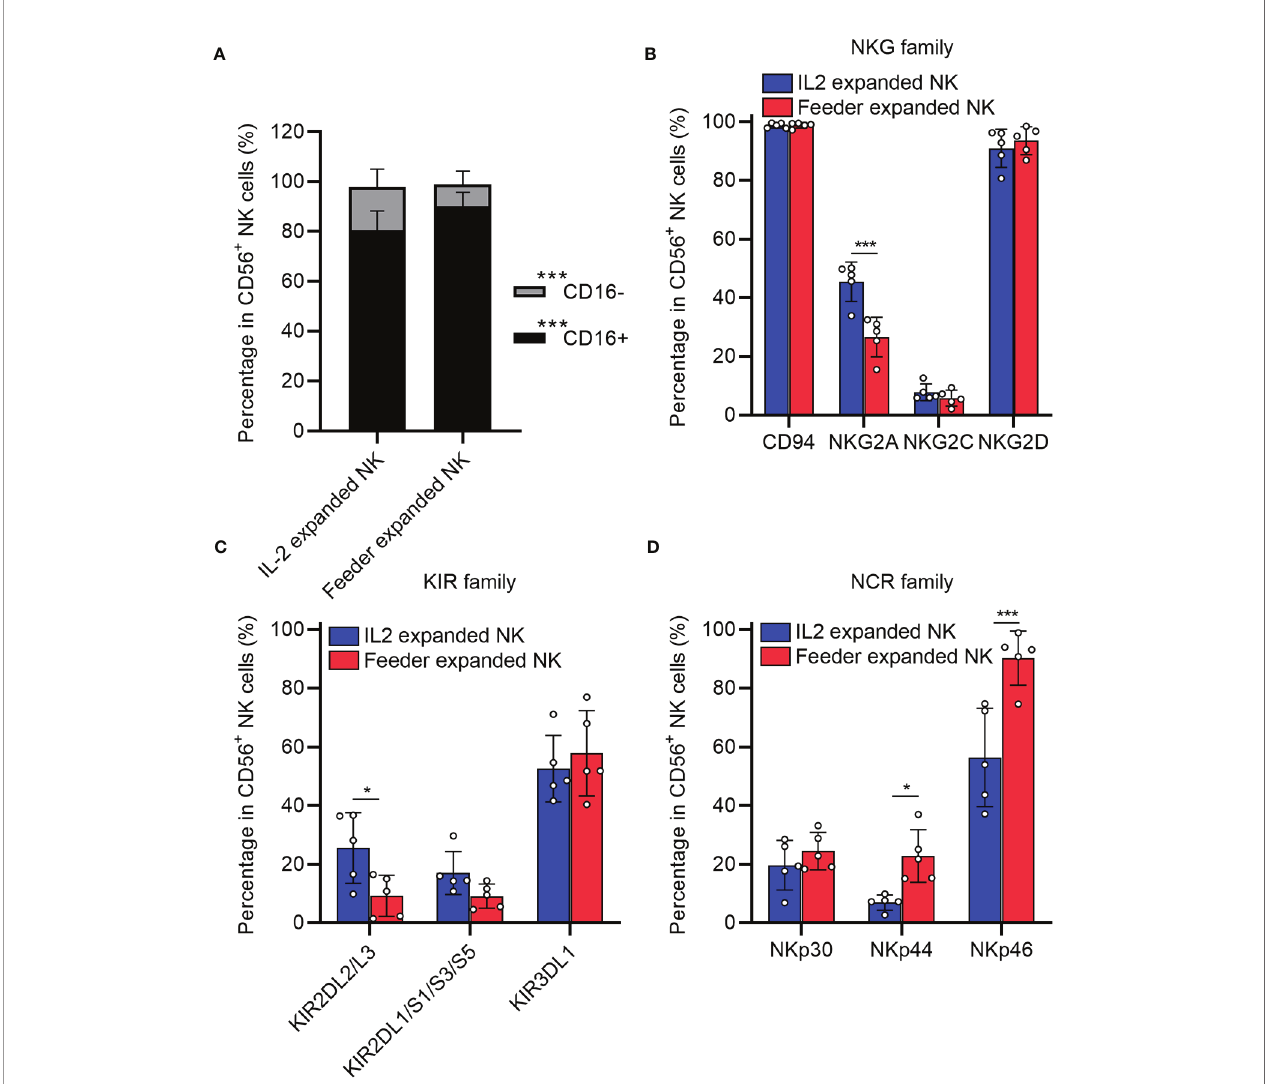
FIGURE 3 | Phenotypic pro fi ling of feeder expanded NK cells (*p < 0.05, ***p < 0.001). (A) Frequency of CD16 − and CD16 + NK cell subsets in the expanded cells. (B) Expression of natural killer receptors (NKG, CD94/NKG2A/NKG2C/NKG2D) in the expanded cells. (C) Expression of killer inhibitory receptors (KIRs, KIR2DL1/L2/ L3/S1/S3/S5/KIR3DL1) in the expanded cells. (D) Expression of natural cytotoxicity triggering receptor (NCRs, NKp30/NKp44/NKp46) in the expanded